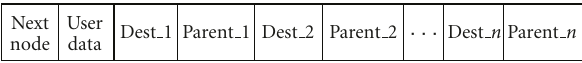
Figure 4: Multicast message used by LBM-MST algorithm.